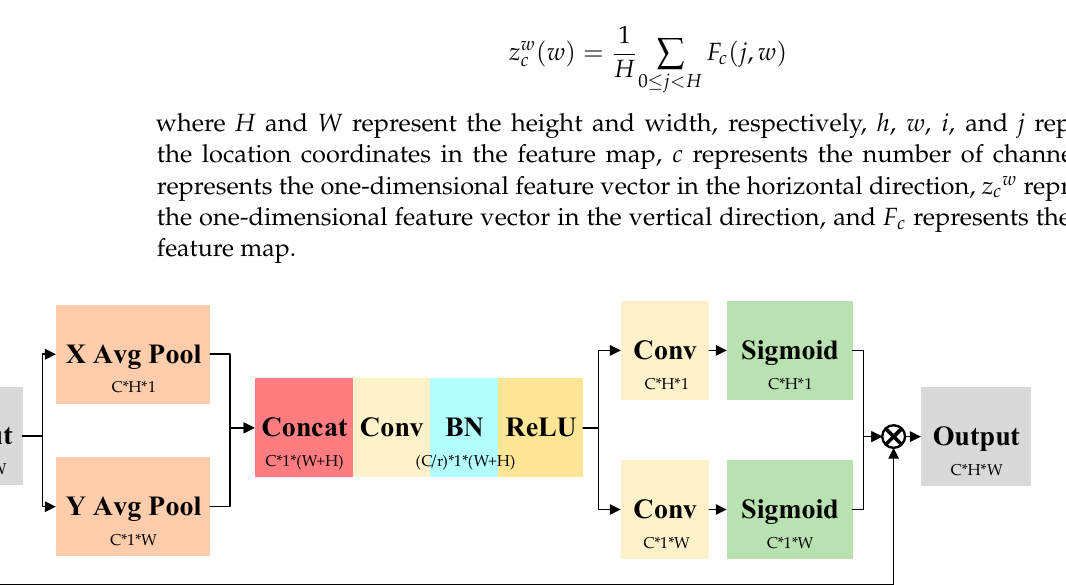
Figure 4. CA attention structure diagram.